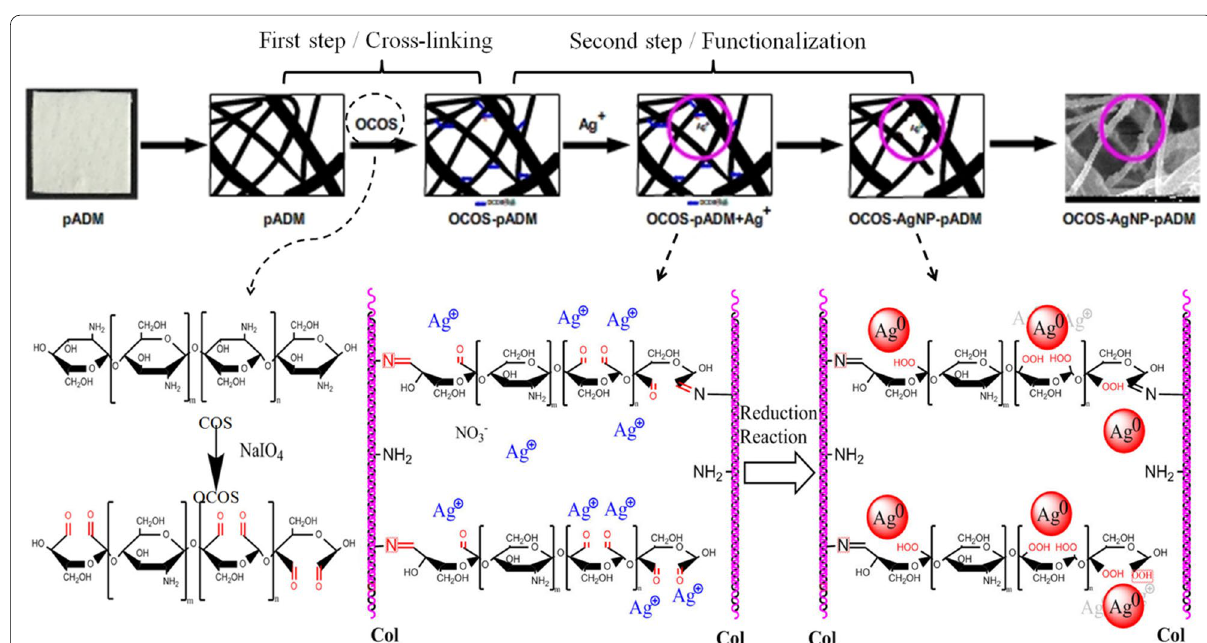
Fig. 5 Schematic outline of the process of in situ synthesis of silver nano particles on oxidized chitosan oligosaccharide cross-linked porcine ADM scaffold. ( Adapted from ref. [52], copyright 2019, with permission from the